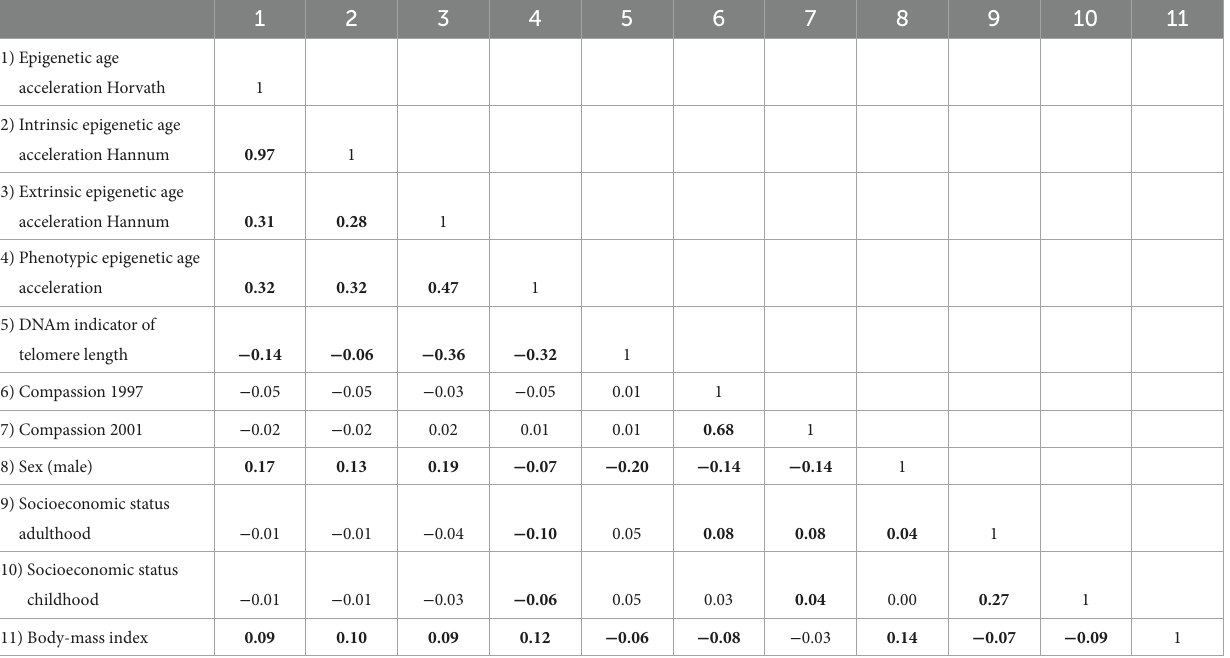
TABLE 2 Pearson correlations between the main study